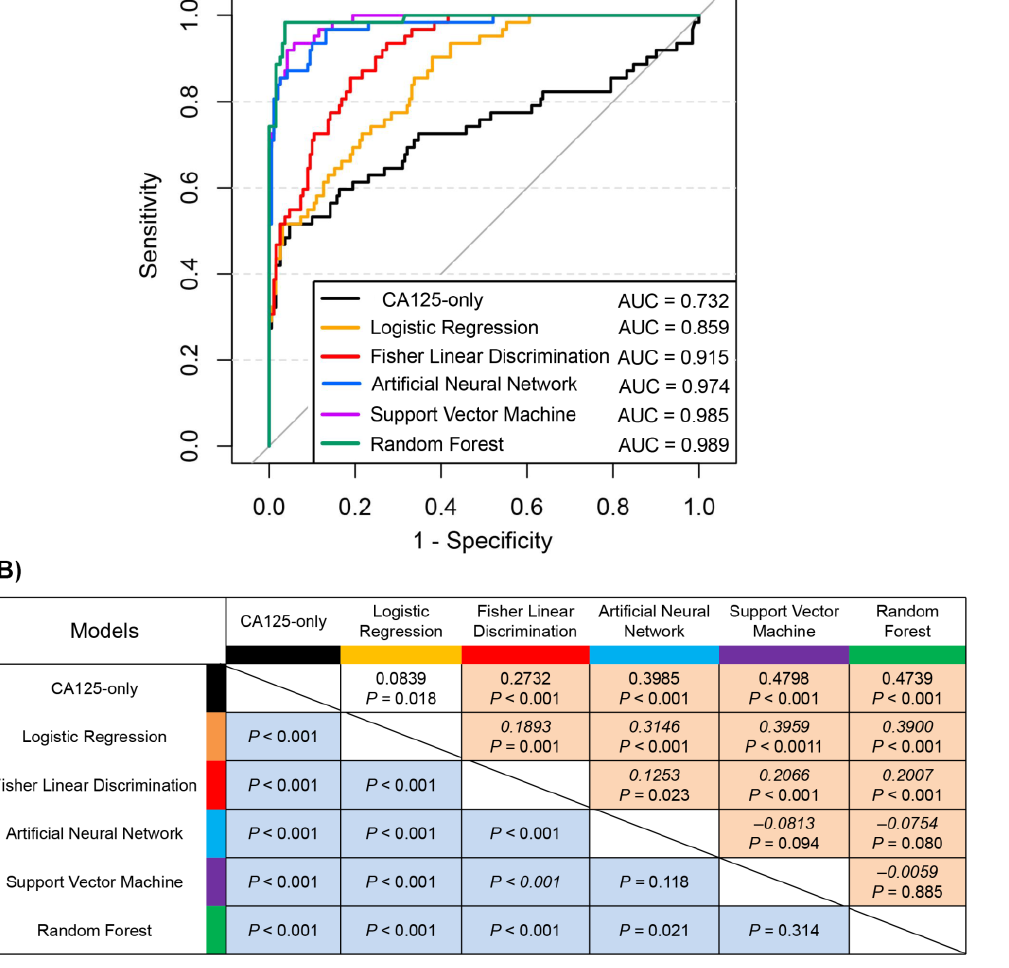
Figure 3. ( A ) Receiver operating characteristic curves for diagnosing ovarian cancer. ( B ) Multiple comparisons between each of the two models for diagnostic efficacy. Note: The datas in the orange cells are the net reclassification index (NRI) (%), and the p -value reflects the difference test between the two models. If the NRI is more than 0, it means that the model above the cell has better classification ability than the model on the left side of the cell, and vice versa if the NRI is less than 0. The datas in the blue cells are the p -values of the difference tests for the area under the curve of the two diagnostic